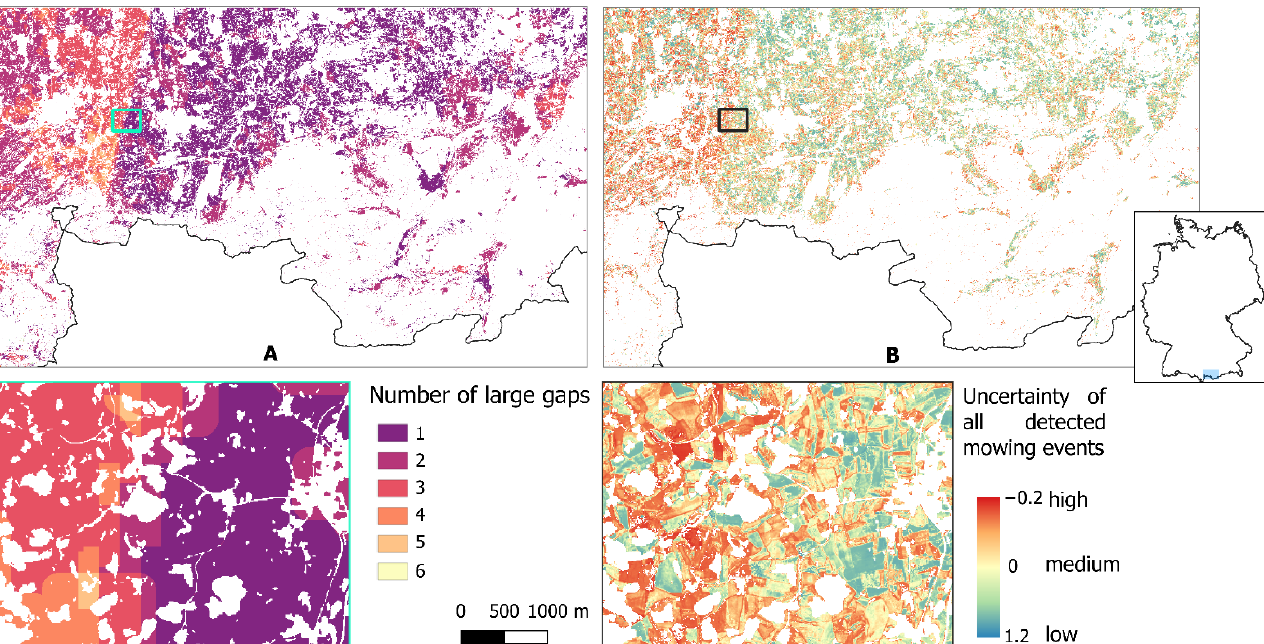
Figure 13. Fractions of grasslands within counties, which are used intensively (mown four to six times; ( A )), extensively (mown zero to two times; ( B )), and mown before the ecologically critical 1st of June ( C ).